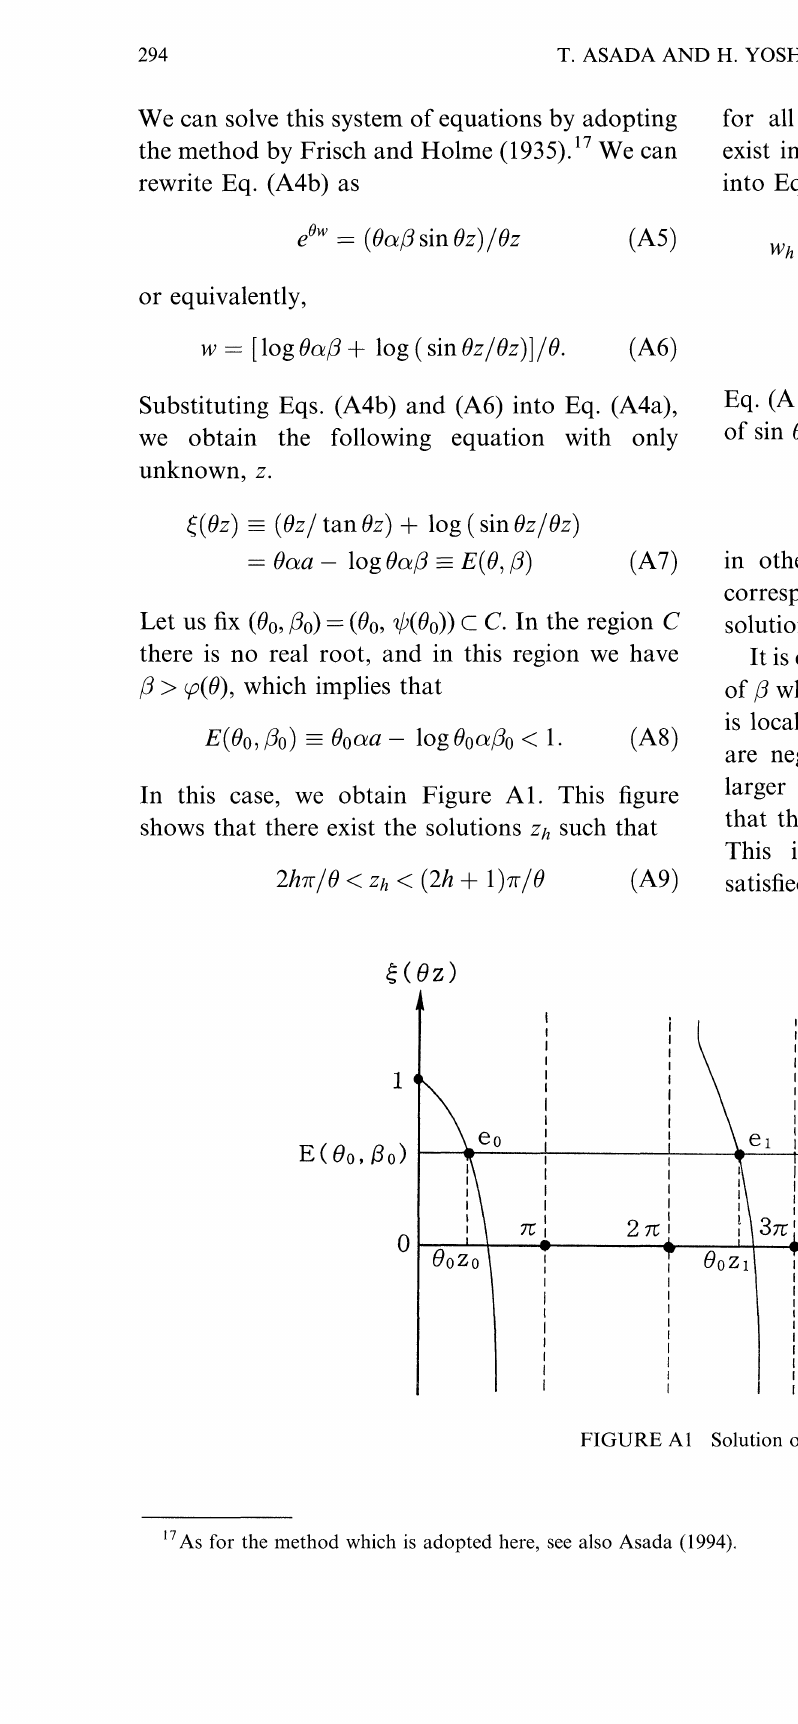
FIGURE A1 Solution of z.